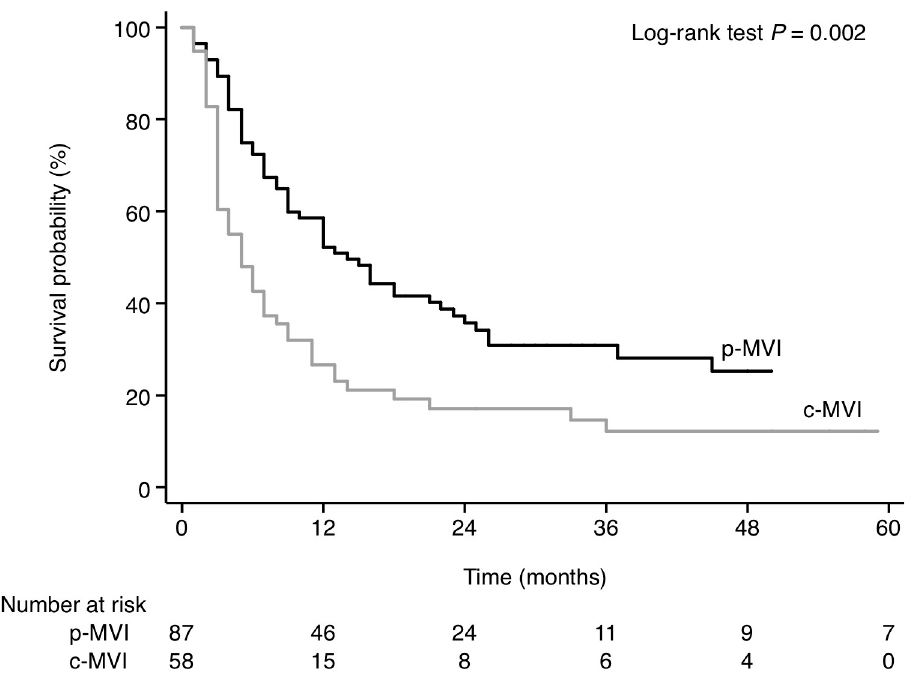
Fig 4. Survival of patients according to the type of MVI extension (black line, p-MVI; gray line, c-MVI). c-MVI was defined as central (portal trunk) portal vein tumor thrombus (PVTT). p-MVI was defined as peripheral PVTT.